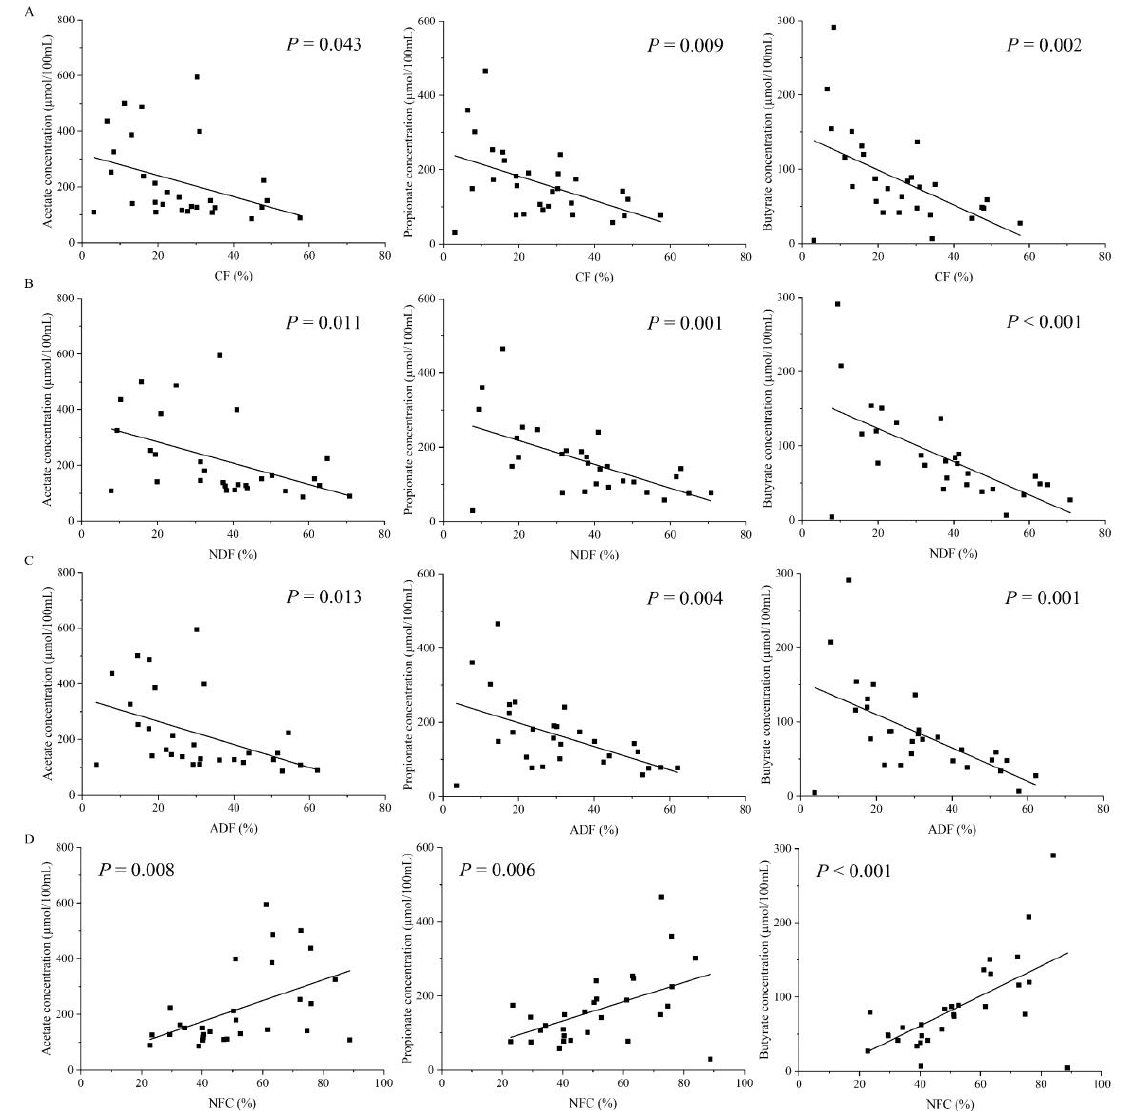
Figure 4. Correlation analysis of acetate, propionate, and butyrate concentrations with crude fiber (CF; ( A )), neutral detergent fiber (NDF; ( B )), acid detergent fiber (ADF; ( C )), and non-fiber carbohydrates (NFC; ( D )). p < 0.05 indicates significant correlation.